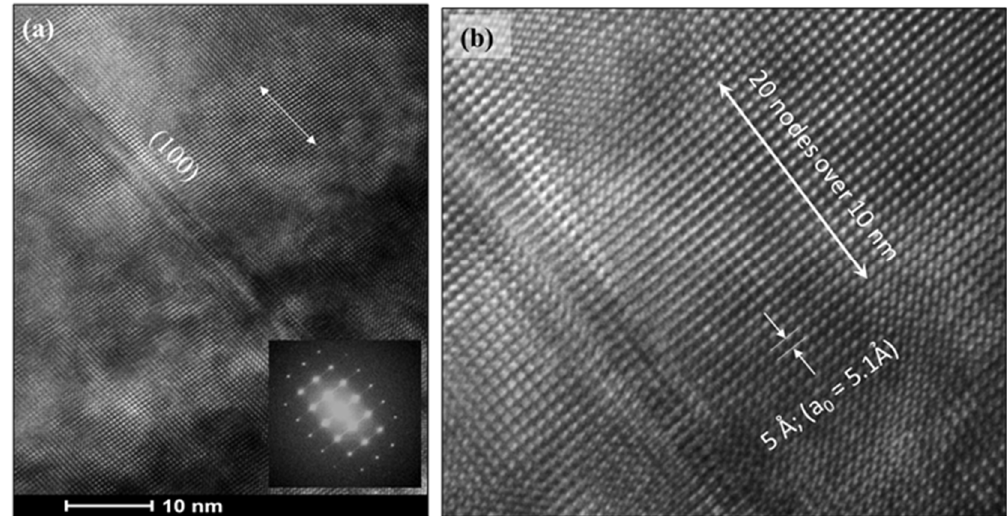
Figure 10. HRTEM images of domain boundary above Figure 9a; ( a ) inset: fast Fourier transform of lattice image; ( b ) enlargement showing node spacing of 5 Ả , corresponding to 5.1 Ả lattice spacing for {100} planes.